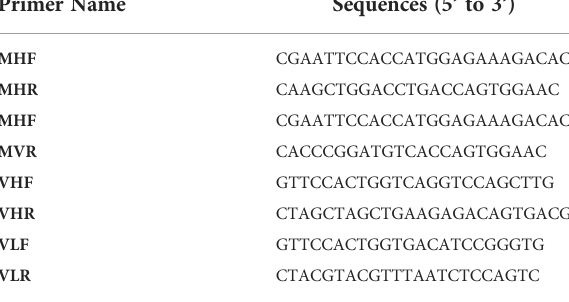
TABLE 1 List of primers used during recombinant development of full-length